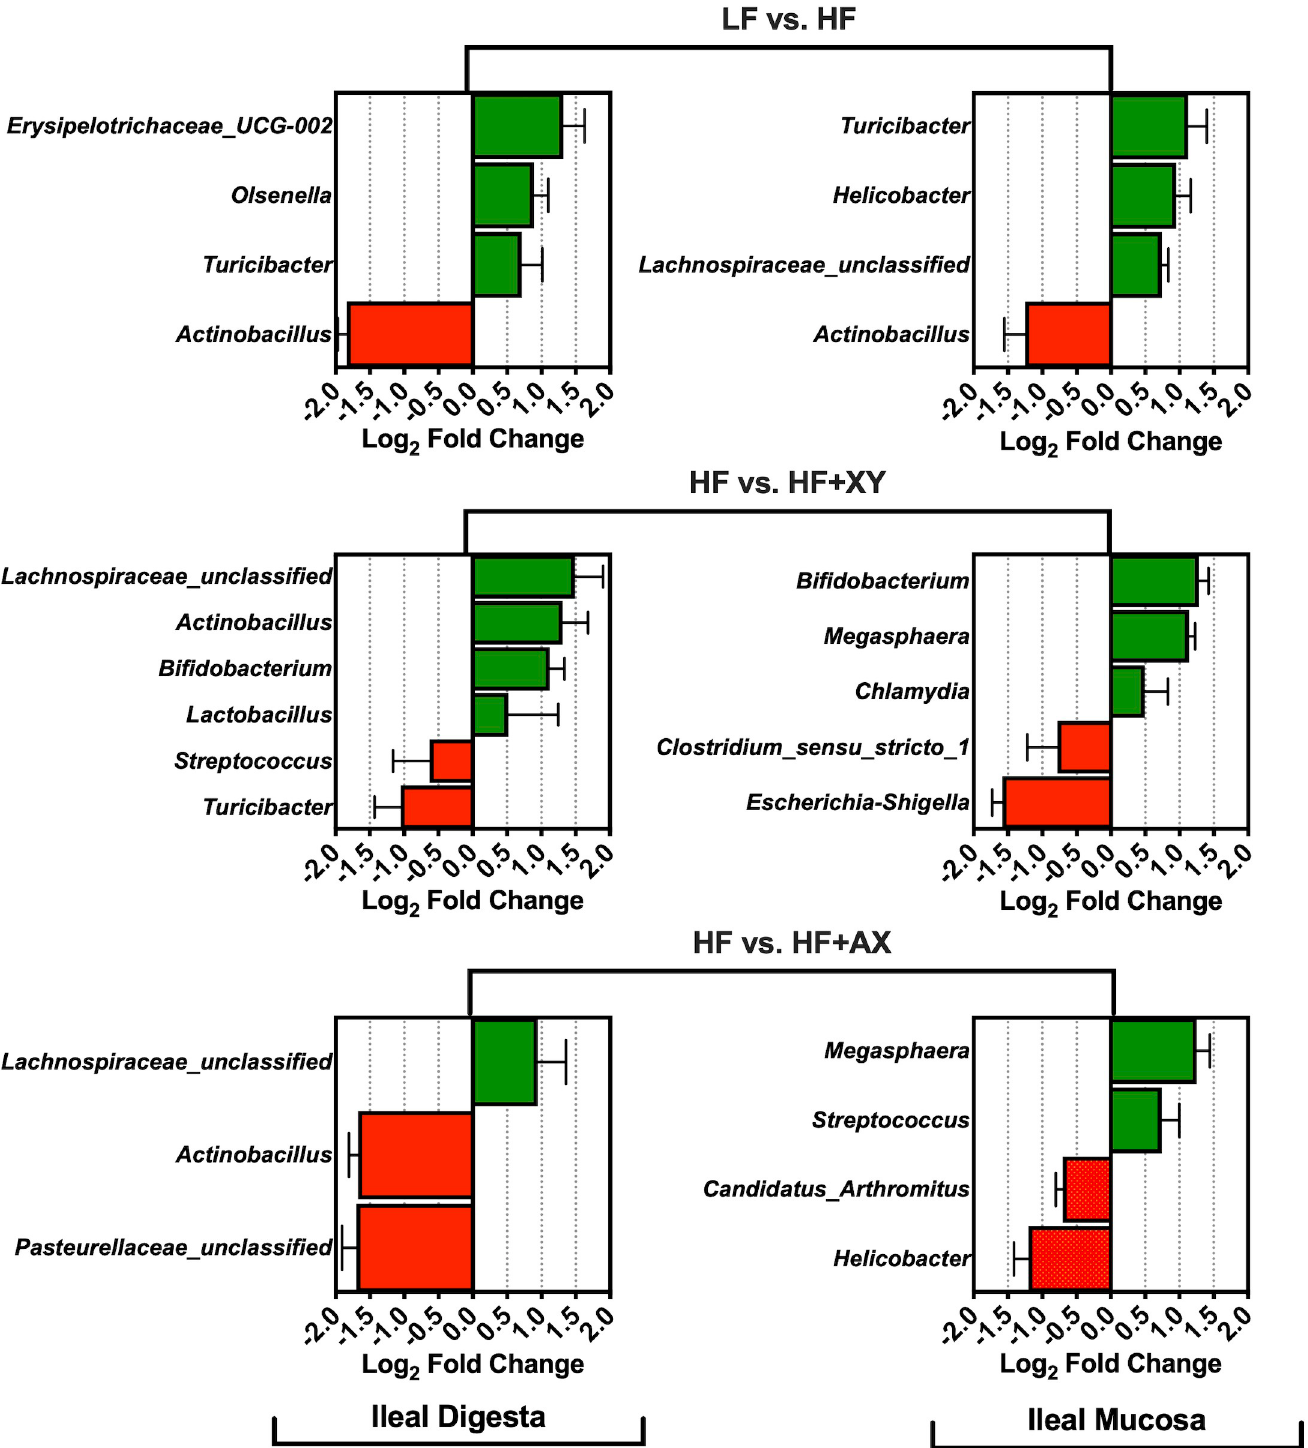
Fig 4. The log 2 -fold change difference between LF vs. HF, HF vs. HF+XY, HF vs. HF+AX for the 15 most abundant microbial genera present in the ileal digesta and mucosa with a Q-value < 0.05.